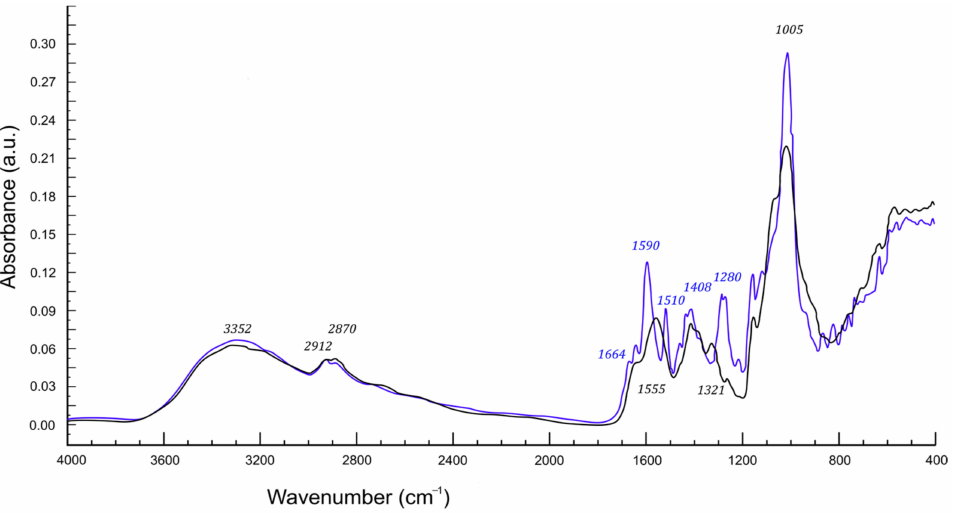
Figure 1. FTIR spectra of Chitosan/CMS mixture (black) vs. pure polymers’ spectra superposition